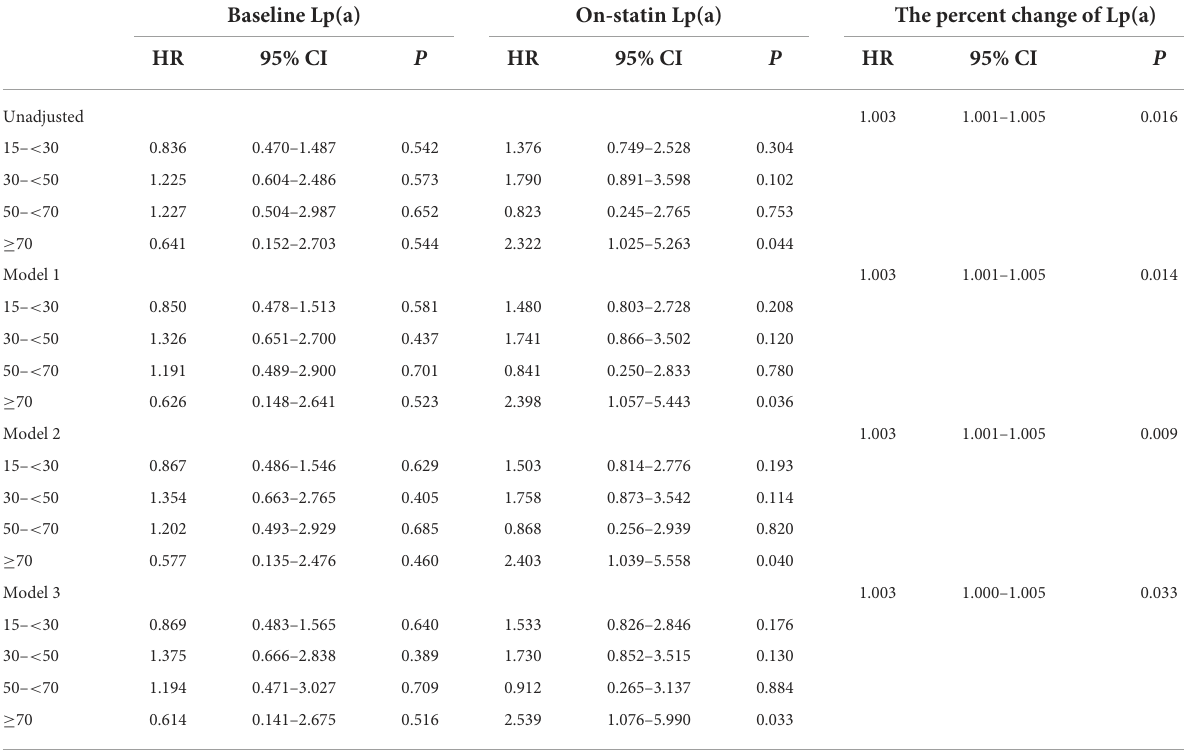
Model 1: adjusted for age, gender. Model 2: adjusted for model 1 plus history of hypertension, diabetes, atrial fibrillation, and coronary heart disease. Model 3: adjusted for model 2 plus LDL-C,HDL-C,TCandTG[baselineLp(a)adjustedforbaselinebloodlipidlevels;on-statinLp(a)adjustedforon-statinbloodlipidlevels;thechangeofLp(a)adjustedforthechangeof